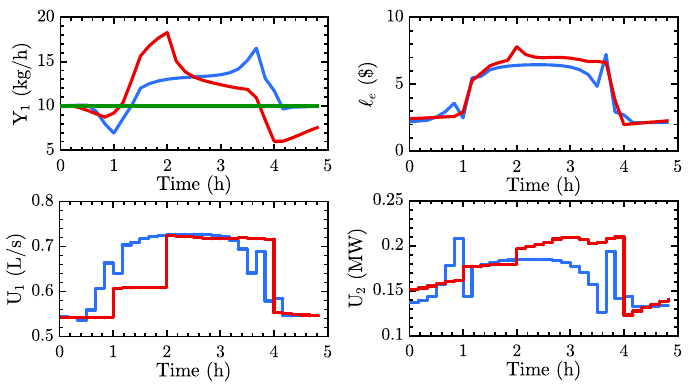
Figure 8. CO 2 emission, input and economic cost trajectories of the PCC plant for scenario 1 with carbon tax set at $200.00 per tonne CO 2 . EMPC (blue), MPC (red), Emission limit (green); ( top-left ) mass flow rate of CO 2 in the treated flue gas; ( top-right ) economic performance of controller; ( bottom-left ) volumetric flow rate of solvent; ( bottom-right ) heat input to reboiler.